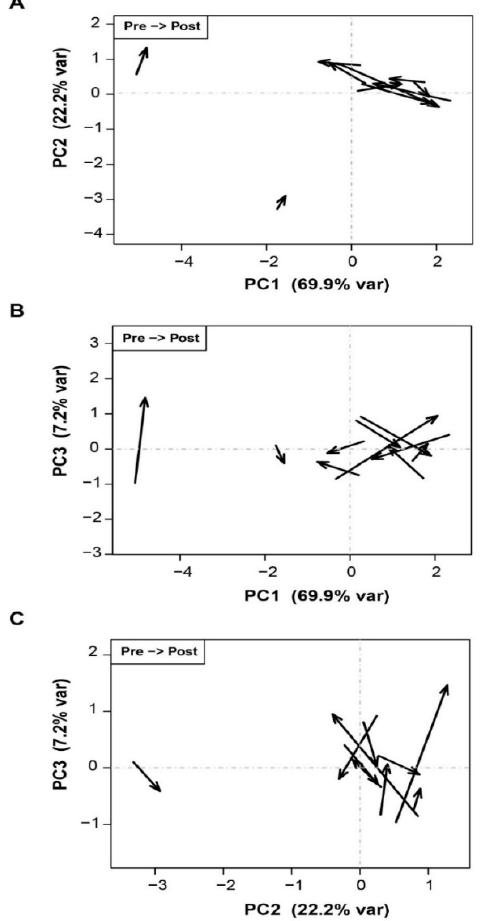
Figure 3. Samples represented on the planes of the first three principal components. Each pair of samples is represented as an arrow, with pre-LT at the tail and post-LT at the head. ( A ) PC2 vs. PC1; ( B ) PC3 vs. PC1; ( C ) PC3 vs. PC2. Table 1. Ability of diversity measures (qD of order 0, 1, 2, infinity, Mfmax, and π ) to predict high or low fibrosis degree at 1 year post-LT using both pre-LT and 15 day post-LT samples. Prediction accuracy of each diversity measure is represented as adjusted